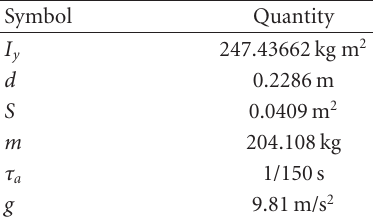
Table 2: Flight Vehicle